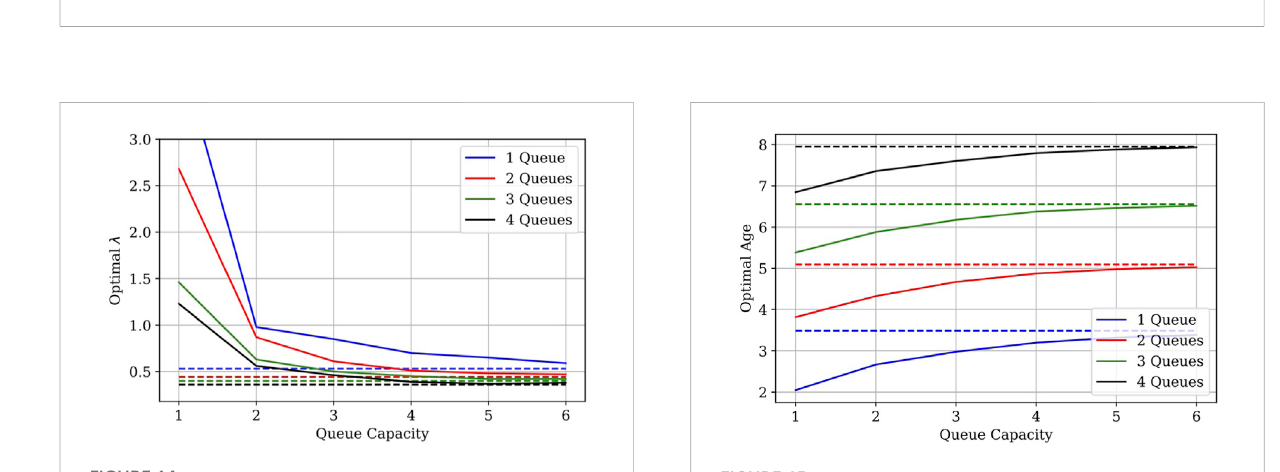
FIGURE 15 Optimalaverageagevs.queuecapacity, μ =1.Thedottedline is the optimal age for in fi nite capacity